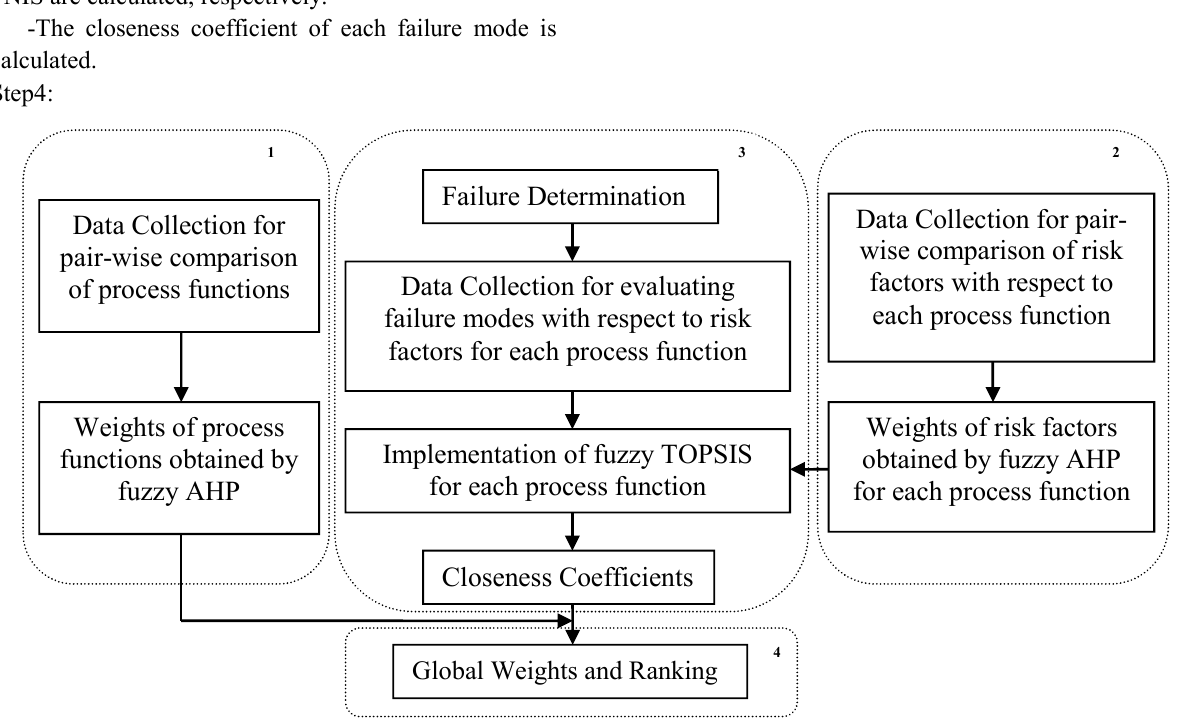
Fig. 1. Flowchart of the Fuzzy